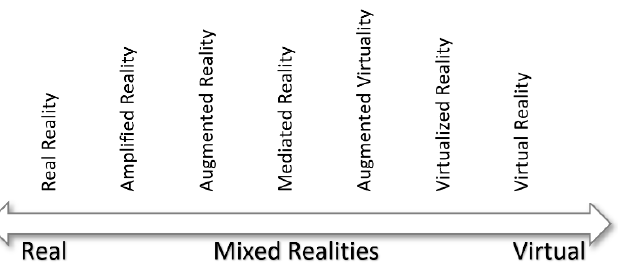
Figure 1. Range of Mixed Realities as it appears in Schnabel et al. 2007, also cited by Schnabel [11] with the description: “Order of reality concepts ranging from reality (left) to virtuality (right)”.